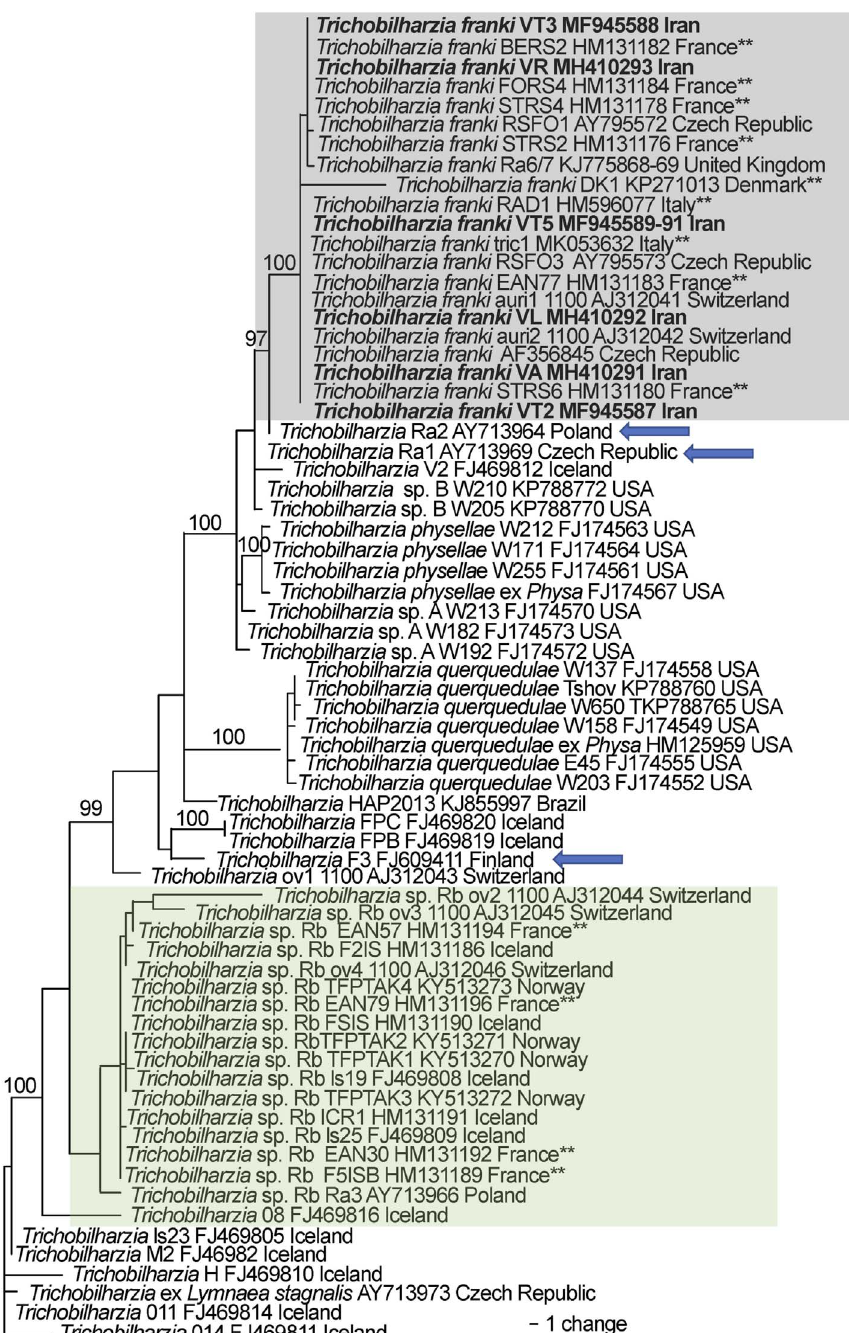
Figure 5. Phylogenetic tree based on Bayesian analysis of ITS1-5.8S-ITS2 with nodal support indicated on the branches by posterior probabilities. The gray boxed clade includes individuals of Trichobilharzia franki , all samples from snails are from Radix auricularia and the samples from this study are in bold. Blue arrows point to specimens that were reported from putative R. auricularia outside of the T. franki clade. The green box highlights the “ peregra ” group ( sensu [37]); these species are often confused for T. franki but mostly come from A. balthica . The double asterisk indicates that the snail host in the study was also characterized genetically. Taxa are listed with their corresponding GenBank accession number followed by the country of collections (see Table